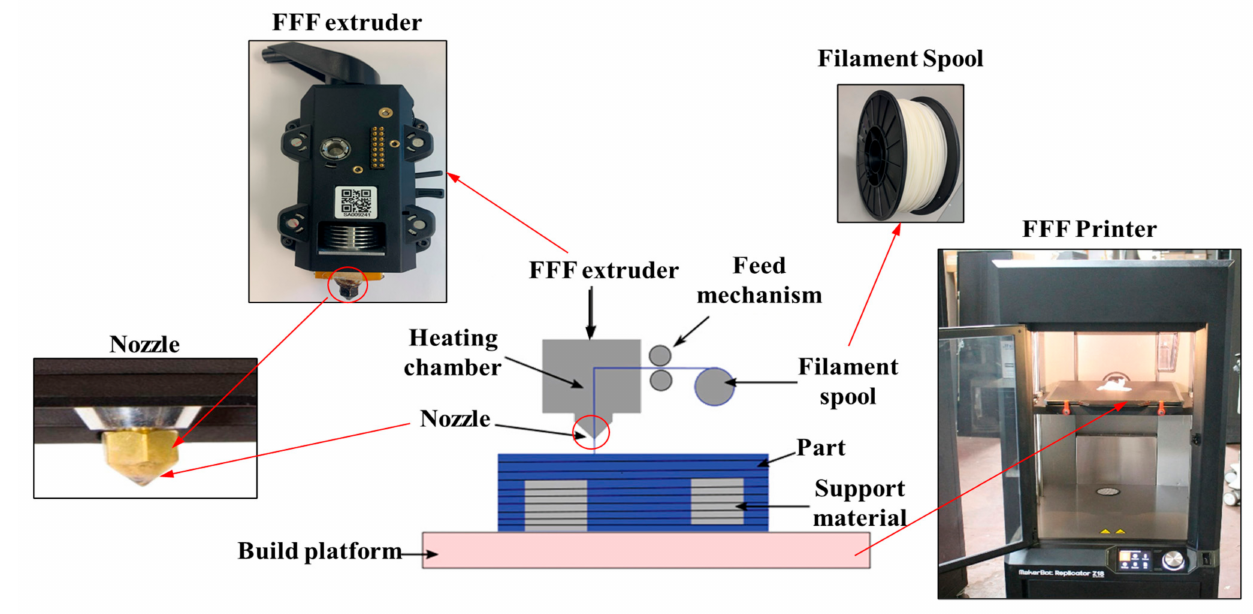
Figure 1. A schematic diagram of the fused filament fabrication(FFF) process [23].